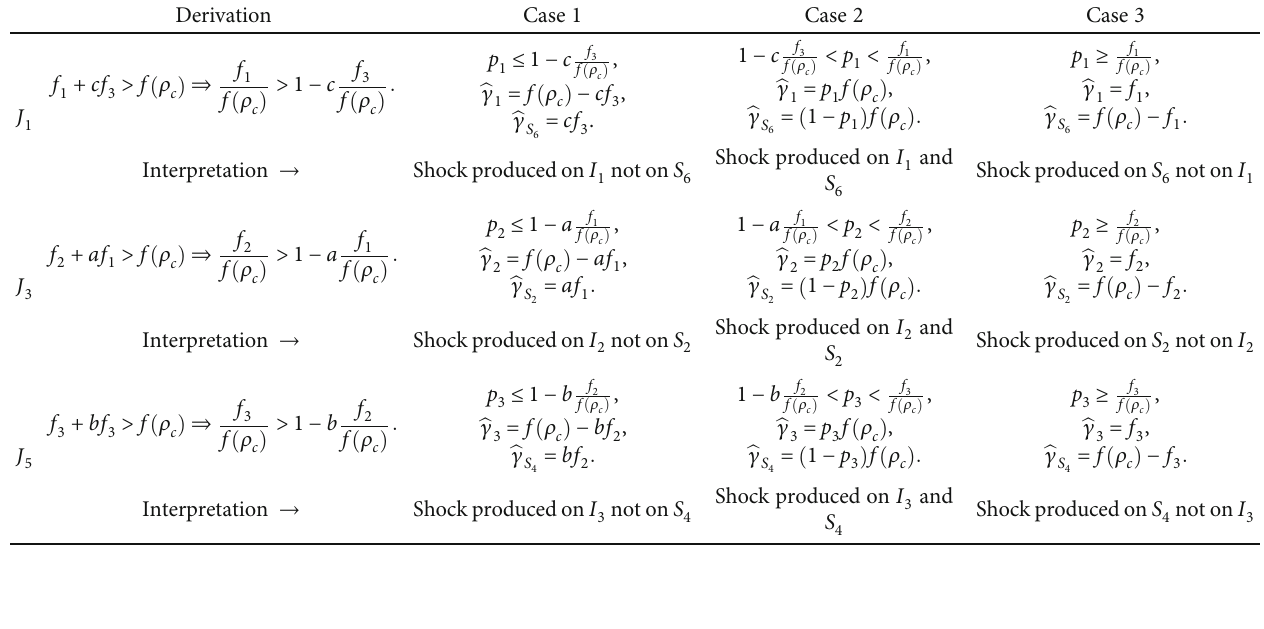
Table 1: Shock wave at merging